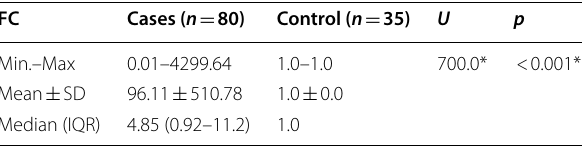
Table 8 Comparison between the two studied groups